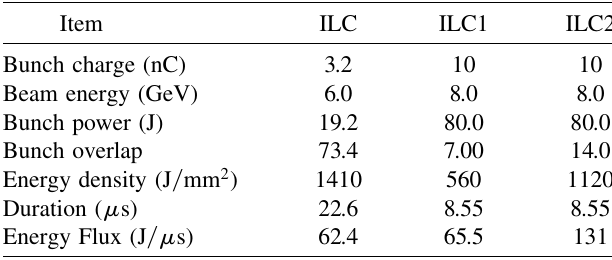
TABLE III. Summary of the beam parameters and expected energy density and flux in the ILC drive beam (ILC) and KEKB operated with ILC modes (ILC 1 and